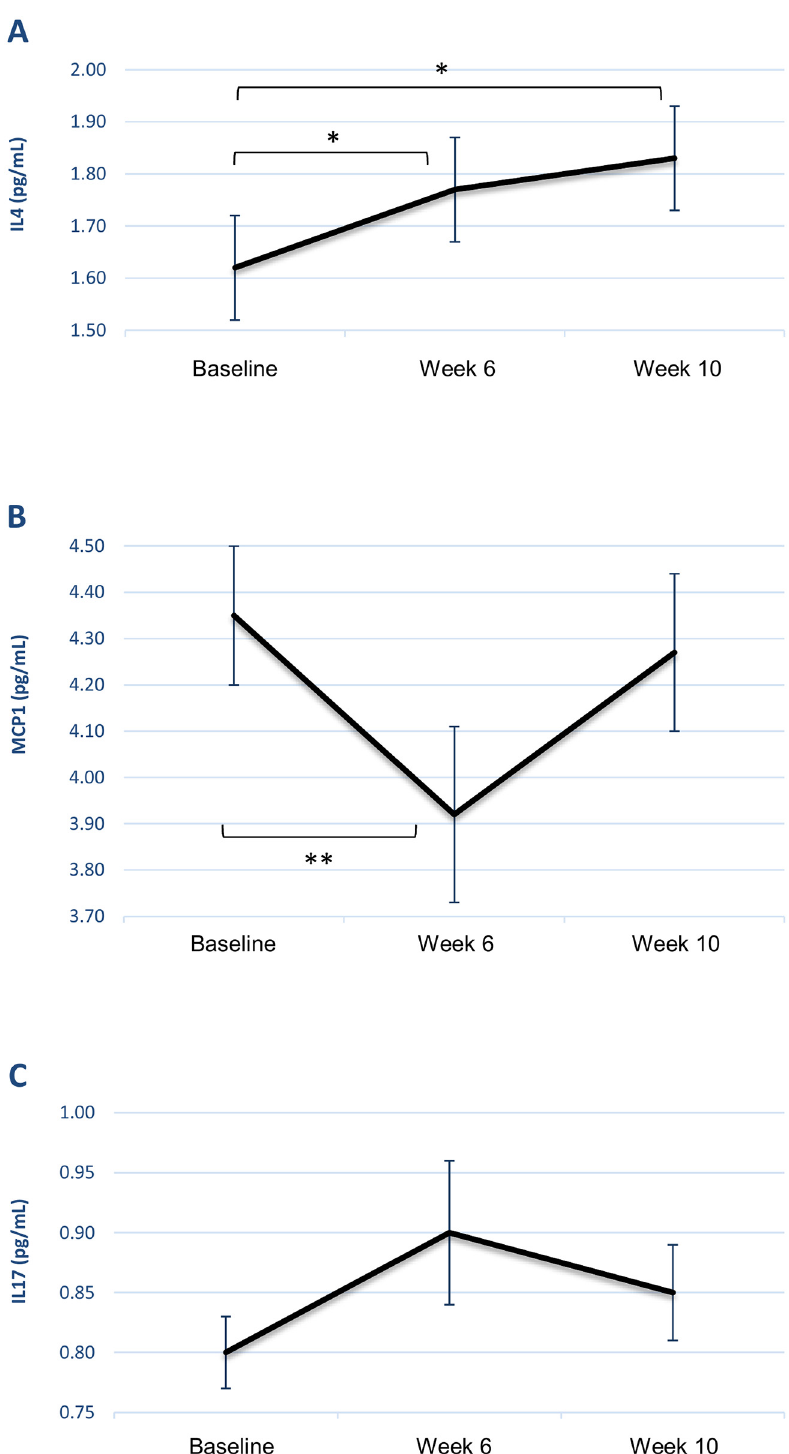
Fig 3. Biological results. Mean cytokines levels (with standard errors) in response to drumming across the 10 weeks for(A) interleukin 4 (IL4), (B) monocyte chemoattractant protein 1 (MCP1), and (C) interleukin 17 (IL17). * = p < .05, ** = p <